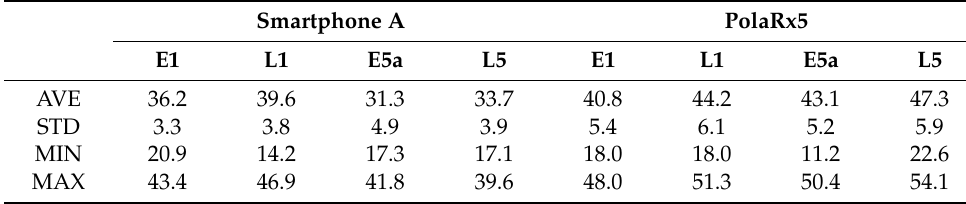
Table 5. Test 3 SNR statistics for smartphone A and PolaRx5 receiver (units: